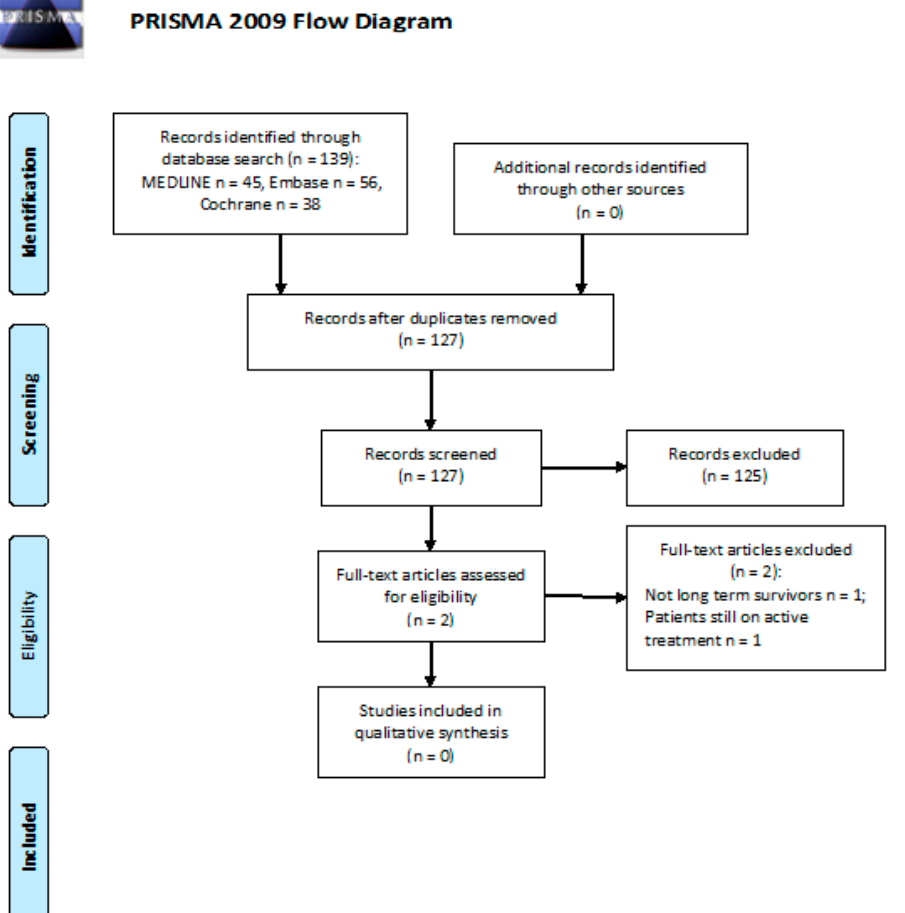
Figure 4. PRISMA flow diagram on the efficacy of follow-up programs for the diagnosis and management of cognitive impairment.